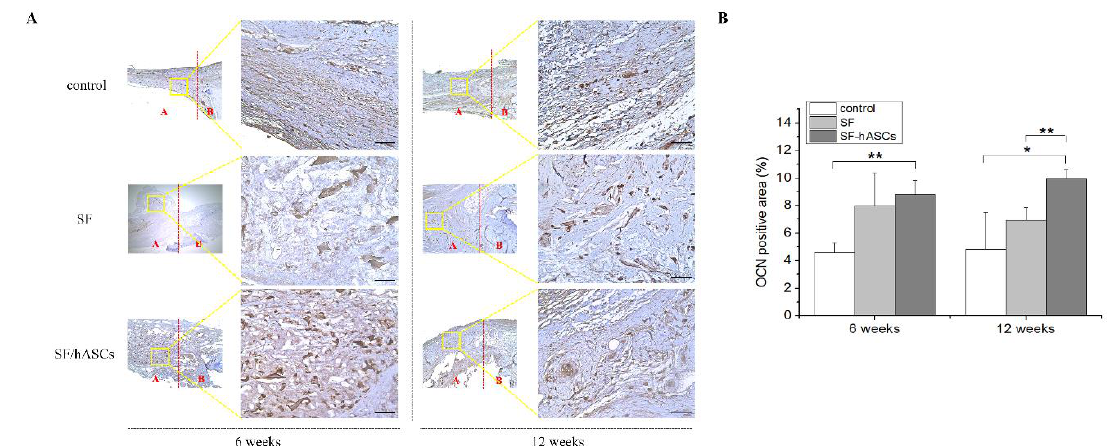
Figure 9. Osteocalcin (OCN) immunohistochemical (IHC) staining of rat calvarial defects in the control, implanted SF sca ff old, and implanted SF-hASCs sca ff old groups. ( A ) IHC staining of OCN positive cells at six and twelve weeks postimplantation in the three di ff erent groups. ( B ) Semi-quantitative analysis of the relative amounts of OCN-positive cells in the three di ff erent groups (*, p ≤ 0.05; **, p ≤ 0.01; scale bar = 50 µ m; red A and B = defect area and host bone area, respectively).